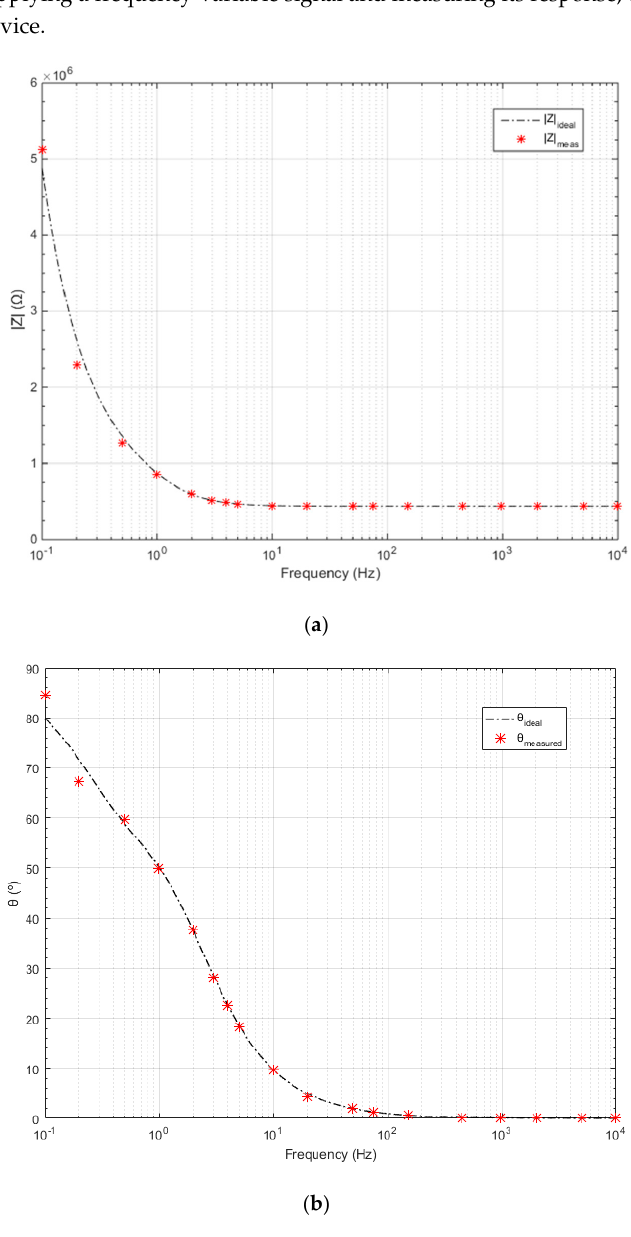
Figure 20. ( a ) Impedance magnitude recovery for 18 different frequencies in the 100 mHz to 10 kHz range. Red dots represent the experimental values recovered, dashed line is the ideal impedance value. ( b ) Recovered (red dots) phase values and ideal behavior.